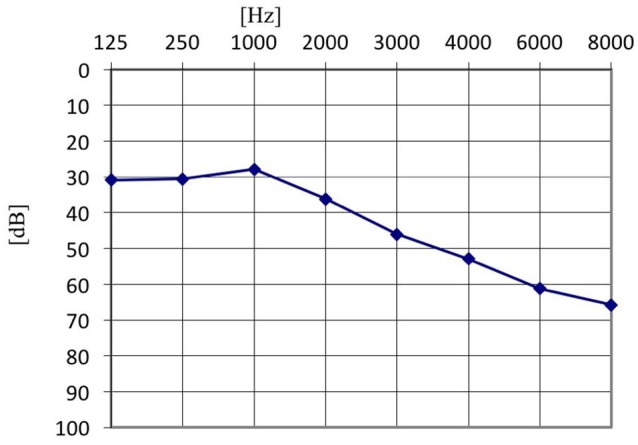
The averaged pure tone audiogram in the tinnitus group–hearing loss tinnitus patients.